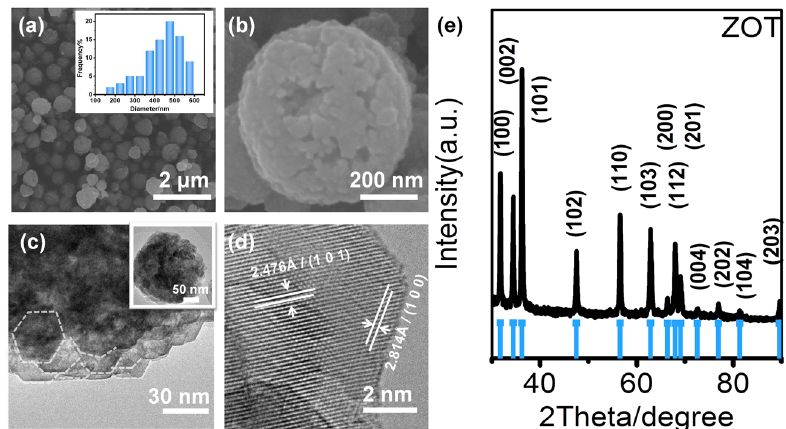
Figure 2: ( a ) and ( b ) SEM images of the as - obtained ZOT. The inset shows the sphere size distribution analyzed from the SEM image; ( c ) TEM image; ( d ) HRTEM image of the as - obtained ZOT; and ( e ) XRD pattern of the as - obtained